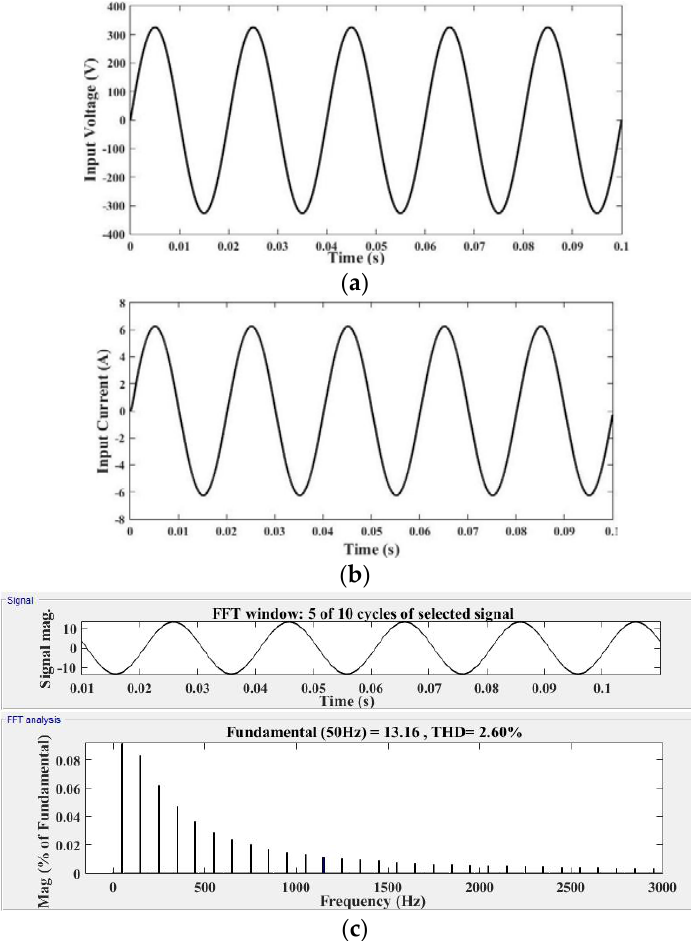
Figure 8. Simulated waveforms of ( a ) input voltage ( V in ) ( b ) input current ( I in ) and ( c ) THD analysis of input current ( I in ).